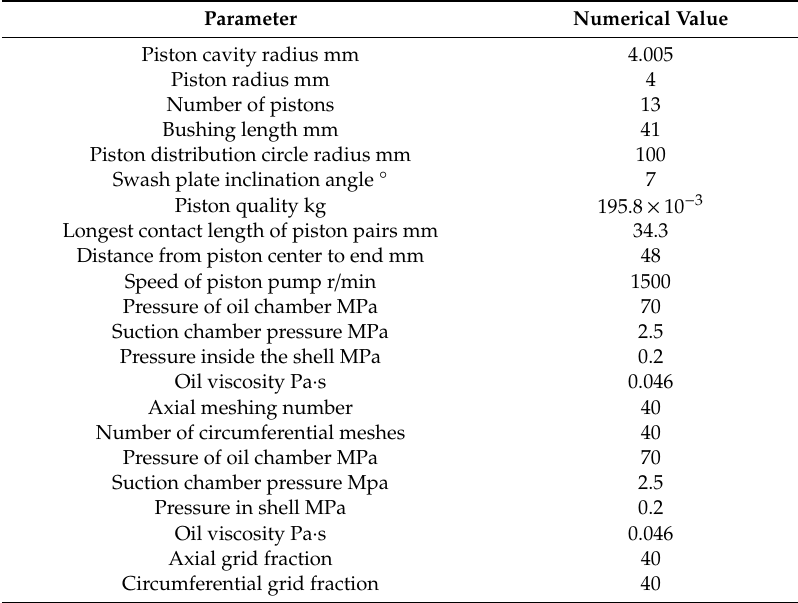
Table 1. Simulation parameter setting.